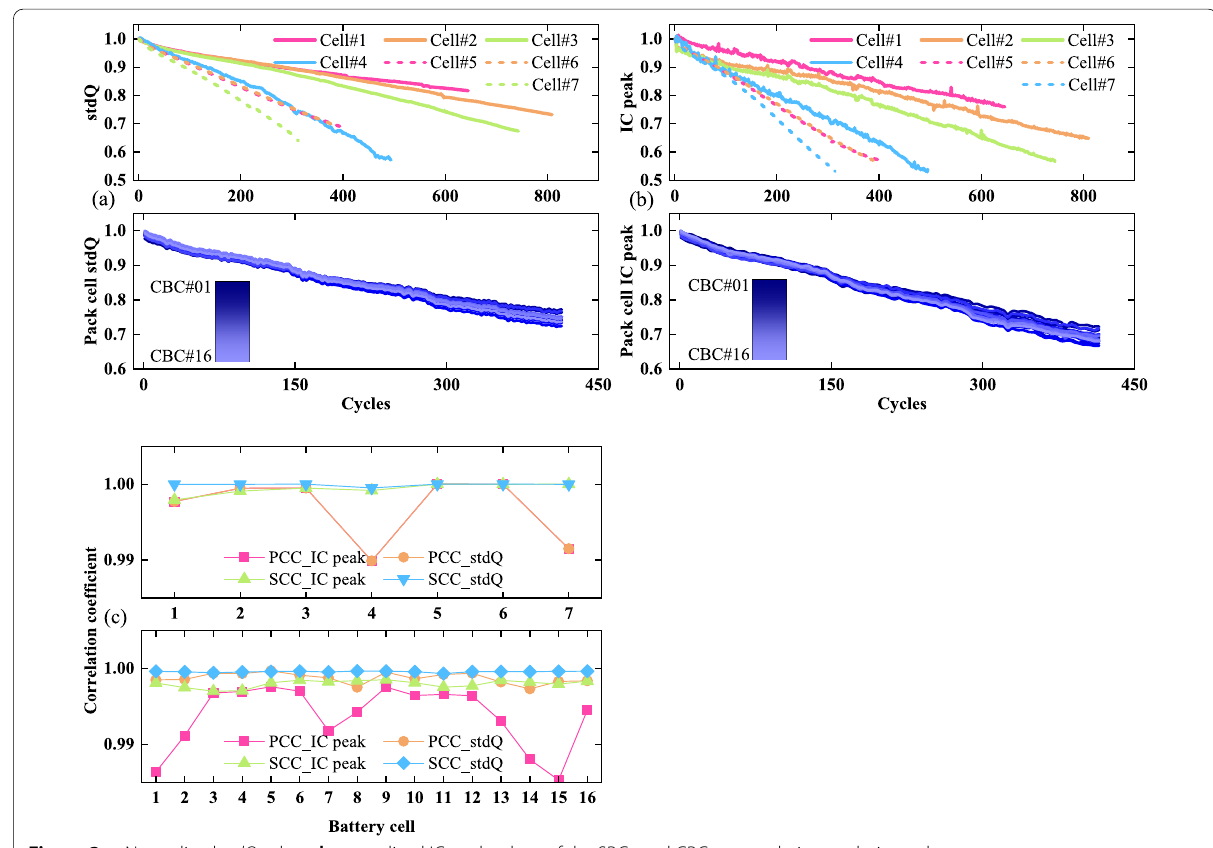
Figure 3 a Normalized stdQ values, b normalized IC peak values of the SBCs and CBCs, c correlation analysis